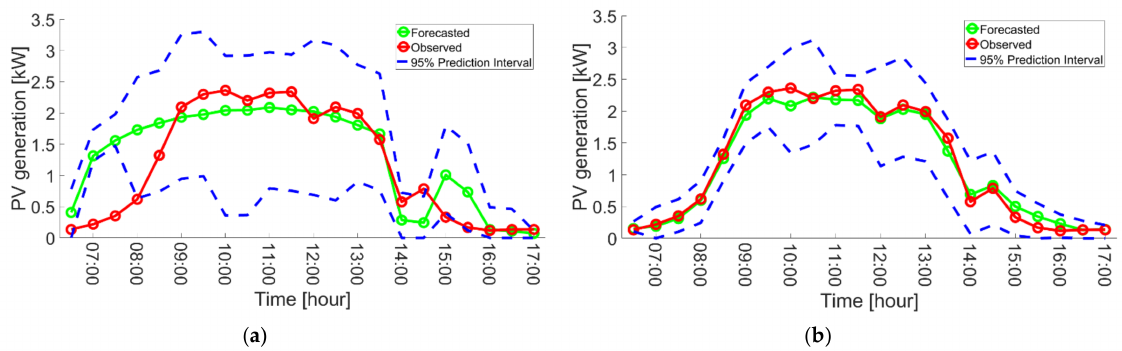
Figure 7. Improvement of forecasted PV generation for PV (iii) on 11 July 2014. The day has the worst PI coverage rate by the single PV forecast model among 30 days. ( a ) Single PV forecast model for PV (iii) (Cover rate = 72%). ( b ) Multiple PV forecast model for PV (iii) (Cover rate =